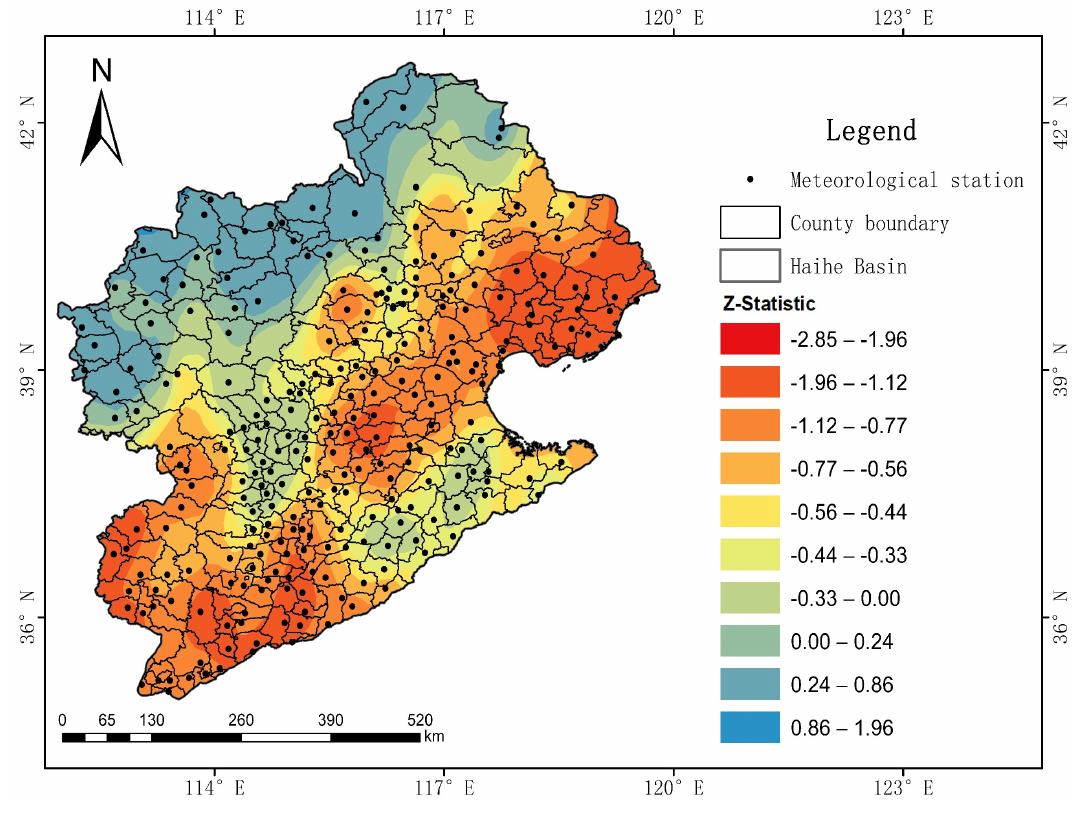
Table 2. Precipitation trends for different seasons in the Haihe River Basin.